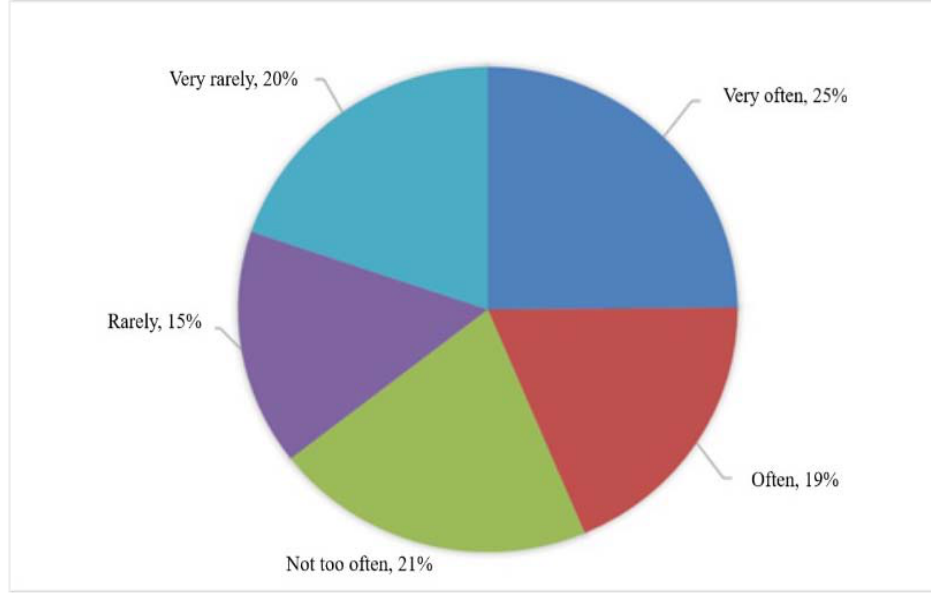
Fig. 6. Popularity of multi-rib Teriva-type